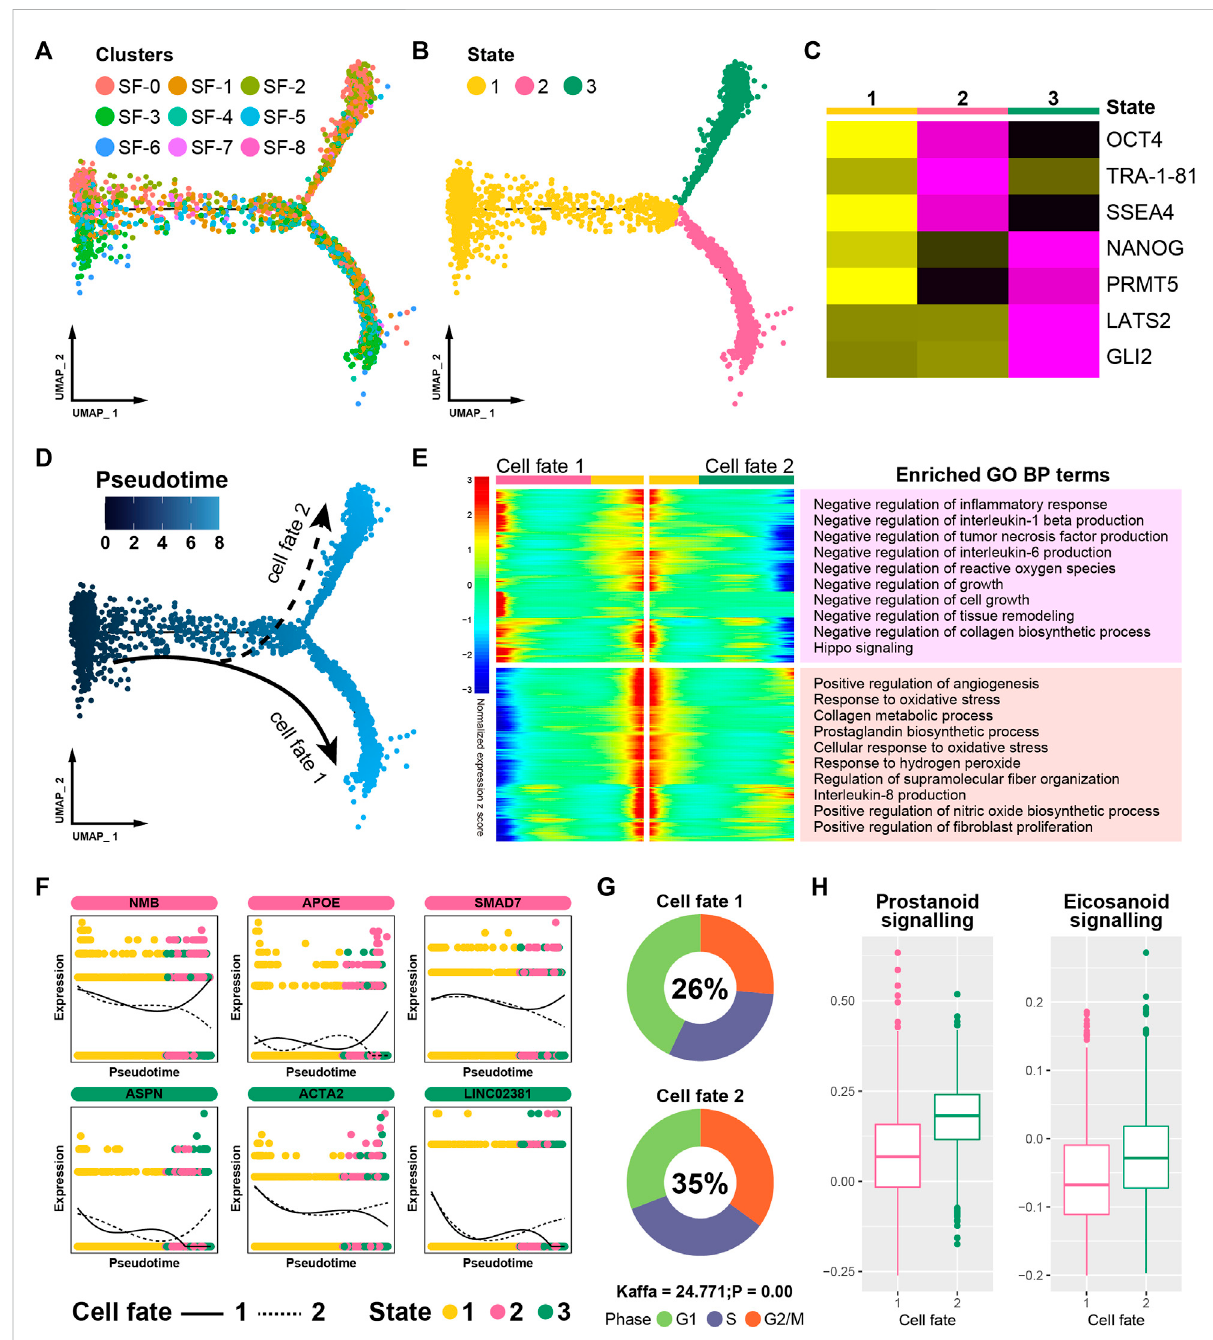
FIGURE 4 Pseudotimeanalysisofthesynovium. (A) Trajectoryplotofdistinctcellclusters. (B) Trajectoryplotofpseudotimestates. (C) Trajectoryheatmap ofdifferentcell states. (D) Trajectory plotof different cell fates. (E) Trajectory heatmap of different cellfates. (F) Branchtrend curves of crucialgenes. (G) Cell cycle distribution of different fates. (H) The activation levels of “ Eicosanoid Signaling ” and “ Prostanoid Signaling ”